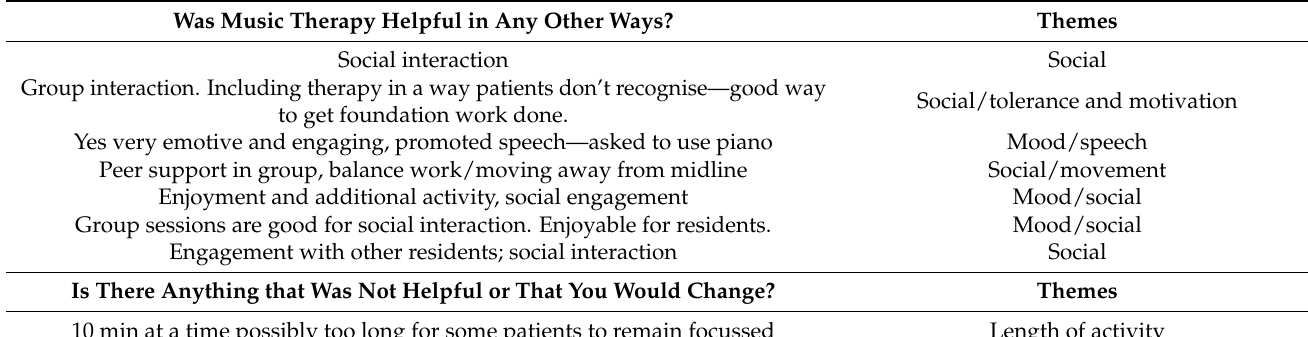
Table A2. Staff members’ qualitative responses to feedback questionnaire ( n = 7).